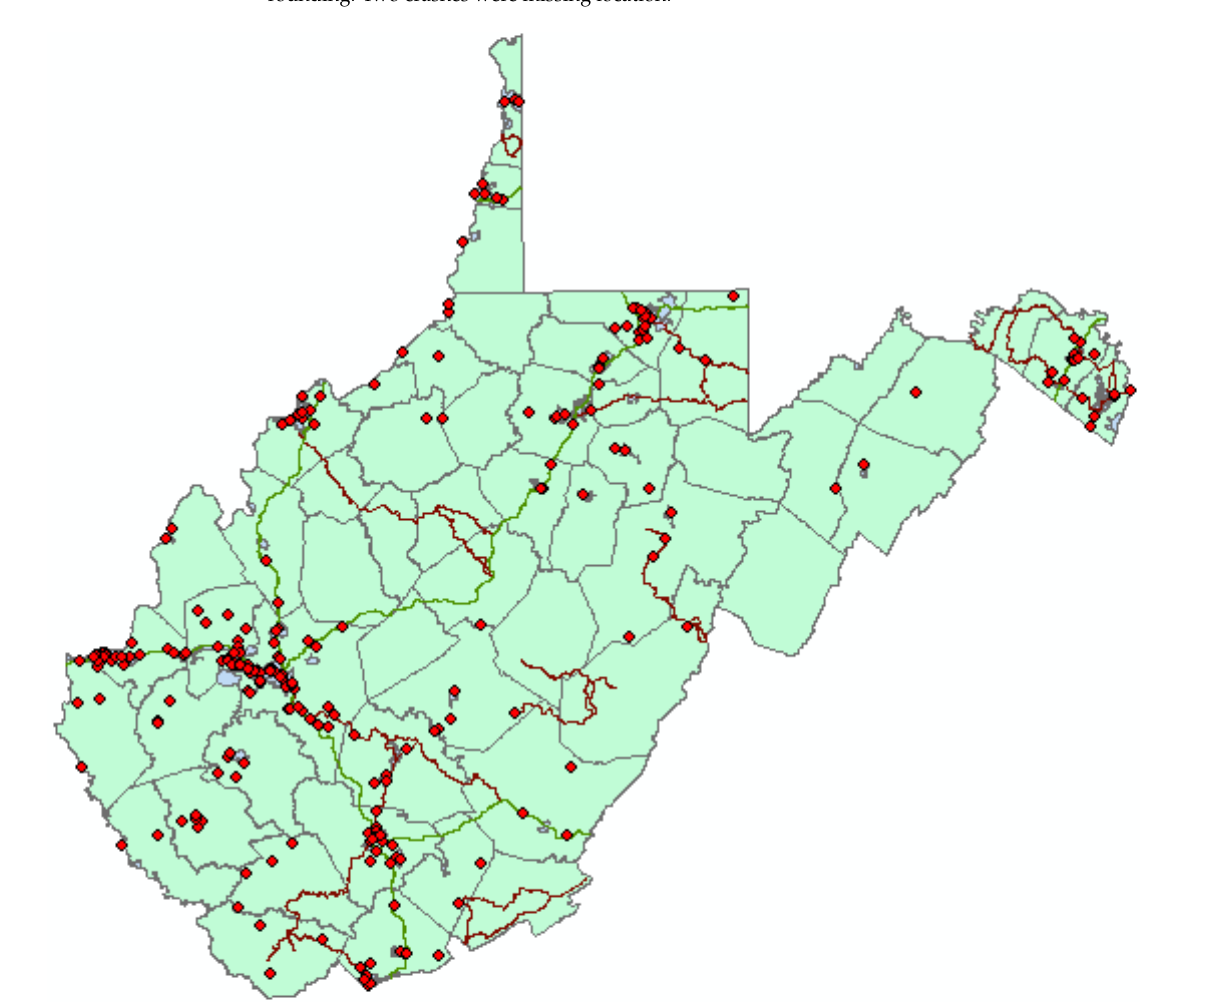
Figure A1. Map of all pedestrian fatalities in WV 2009–2019. Green and burgundy lines represent major roadways. Red diamonds represent individual crashes. Blue-grey areas represent designated towns or cities.